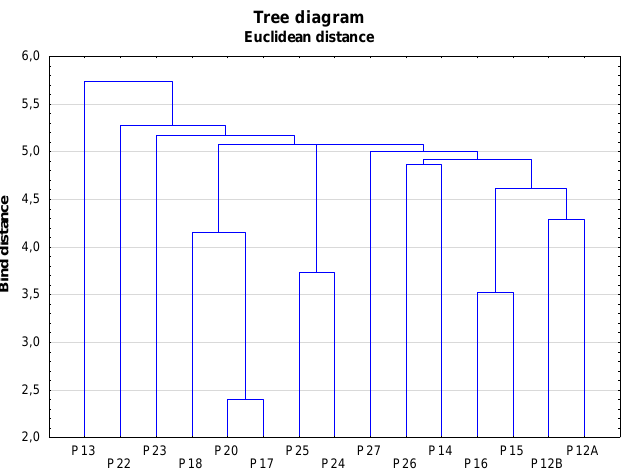
Figure 3. Tree diagram for tangible, intangible, and organizational capital variables.